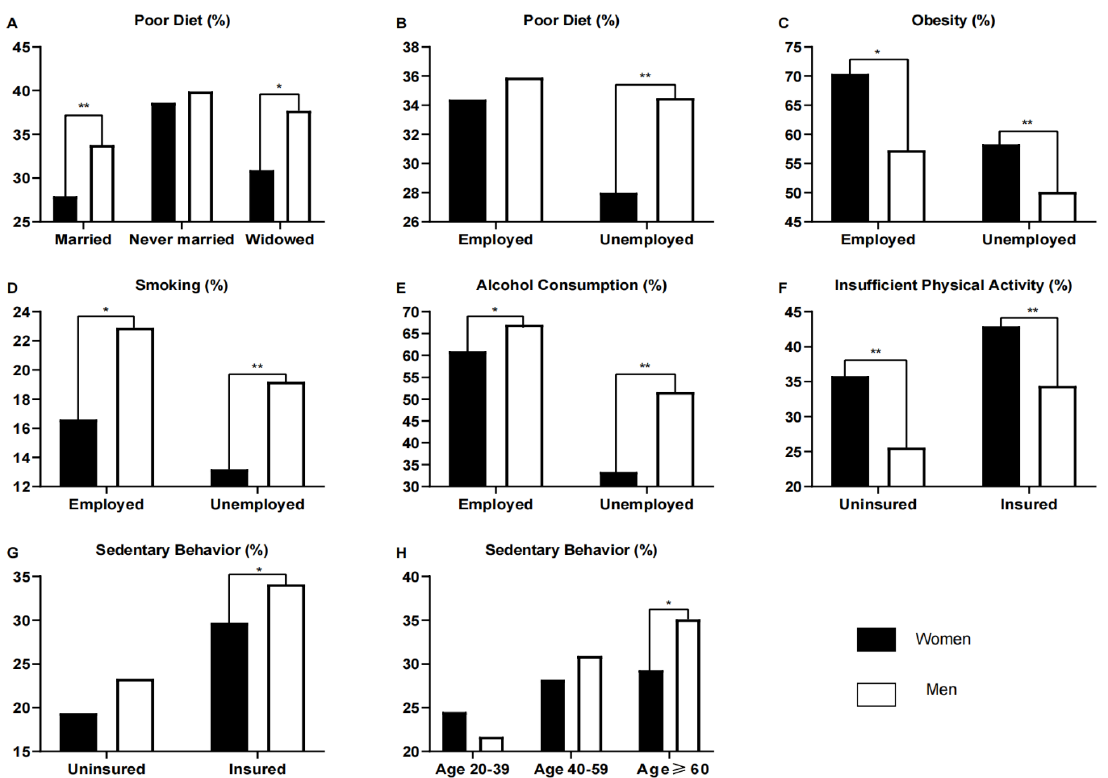
Figure 3. Proportion of participants in the NHANES surveys 1999 – 2018 with diabetes and unhealthy lifestyle behaviors by gender and age, marital status, insurance status and employment status. Mar- ried includes married or living with partners; widowed includes widowed, divorced and